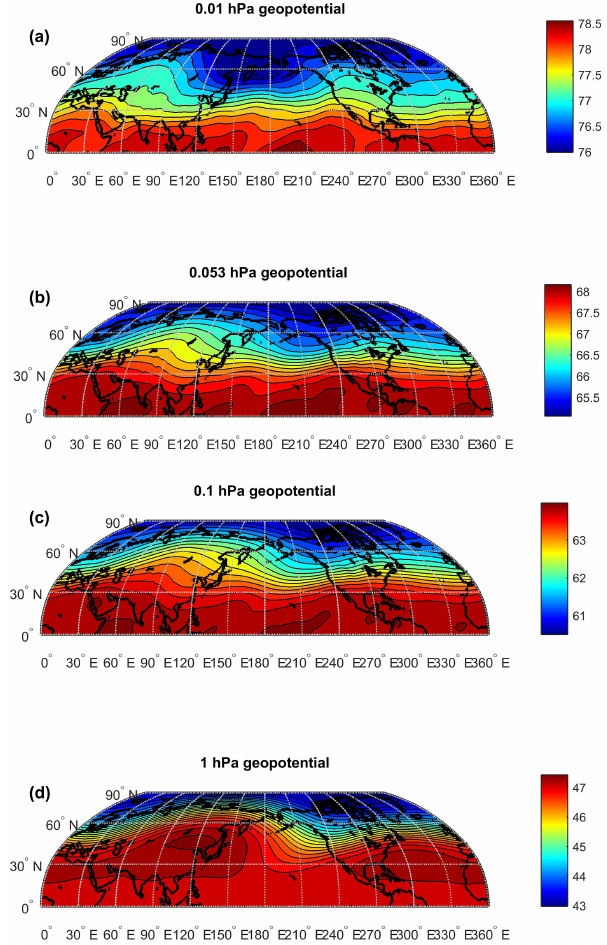
Figure 5. Geopotential heights for January 2005, four pressure lev- els of 1 (a) , 0.1 (b) 0.053 (c) and 0.01hPa (d) , NOGAPS-ALPHA data. Horizontal axis, longitude; vertical axis,